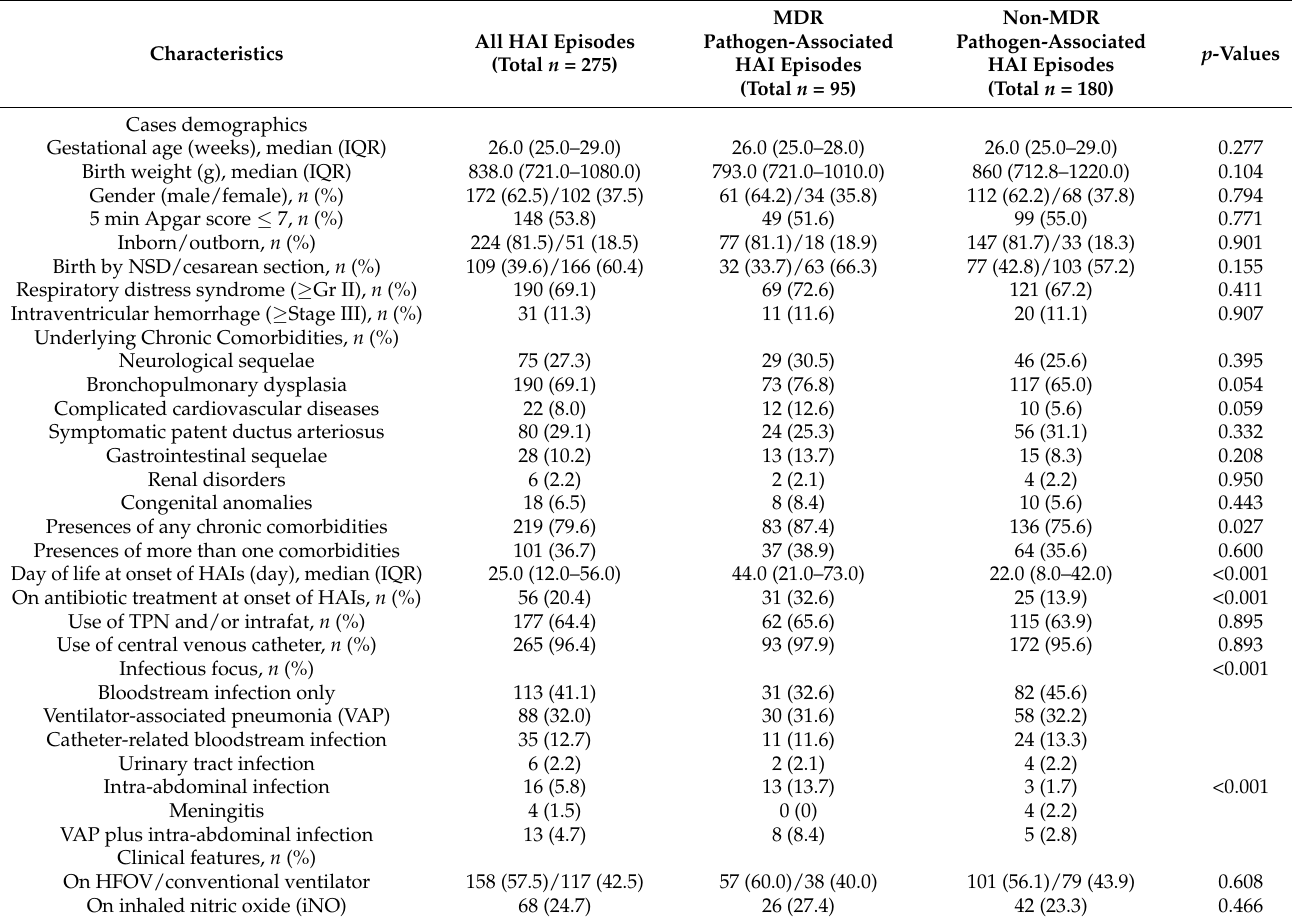
On HFOV/conventional